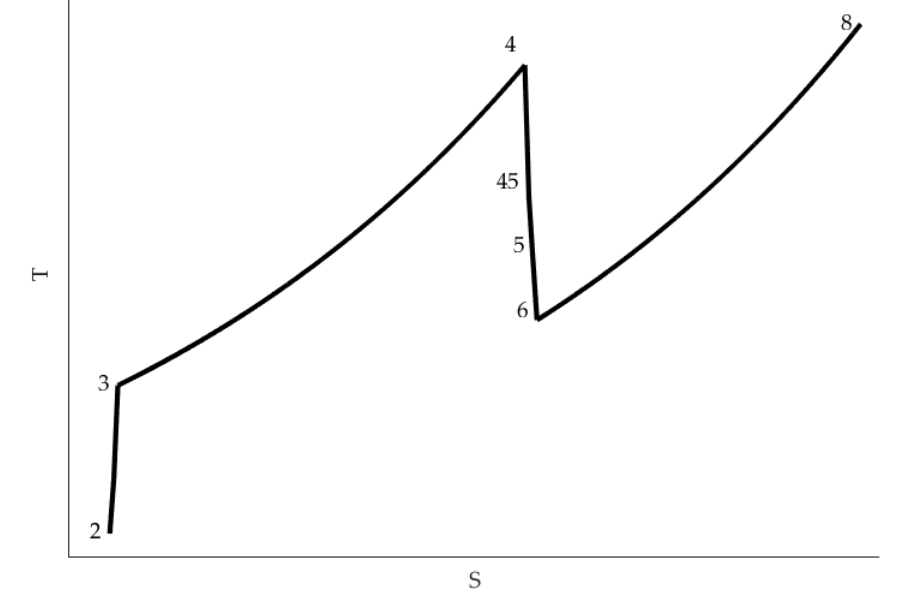
Figure 2. Schematic T-S diagram. Use of afterburner illustrated.